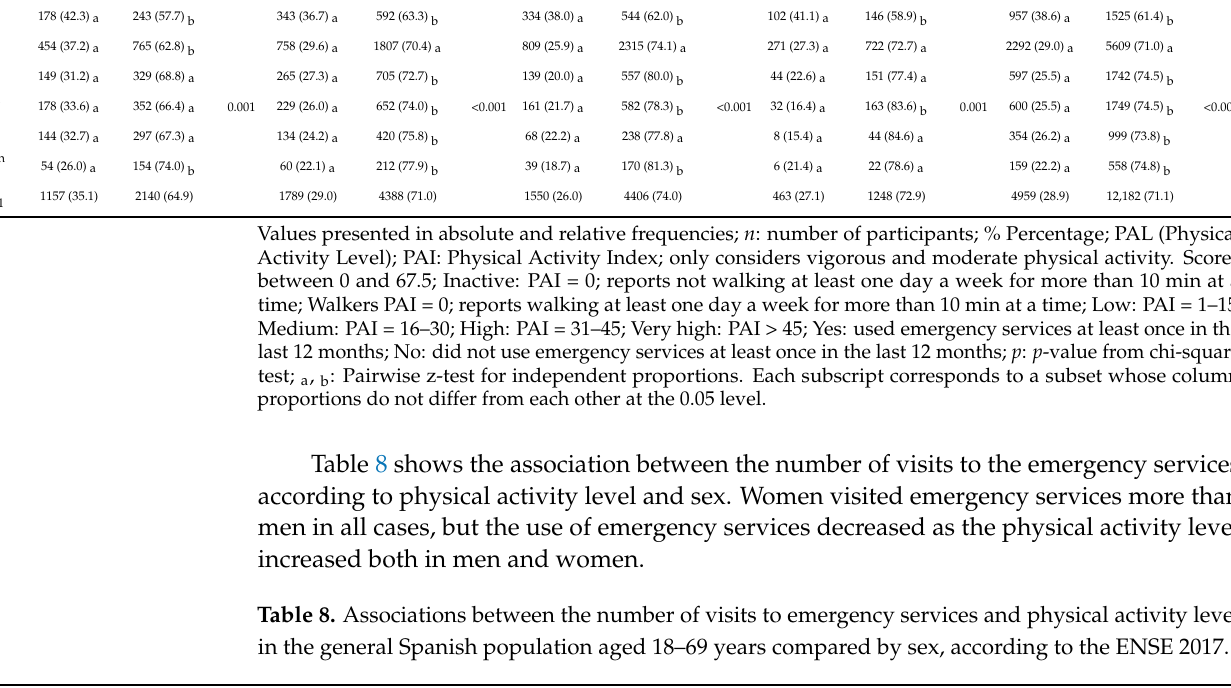
Table 7. Associations between the use of emergency services and physical activity level in the general Spanish population aged 18–69 years compared by age, according to the ENSE 2017.